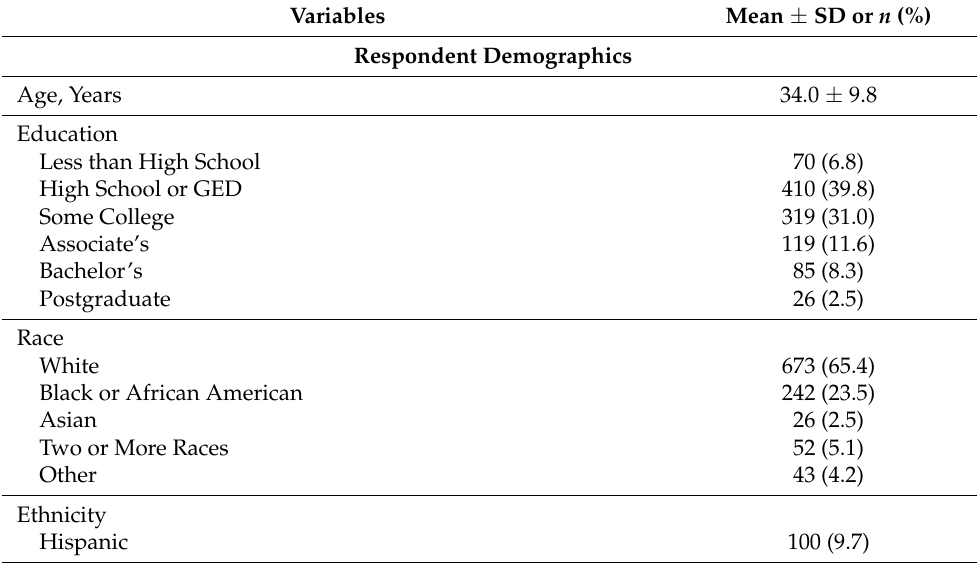
Table 1. Description of survey respondents’ demographics, physical health, mental health, social support, and coping strategies ( n =